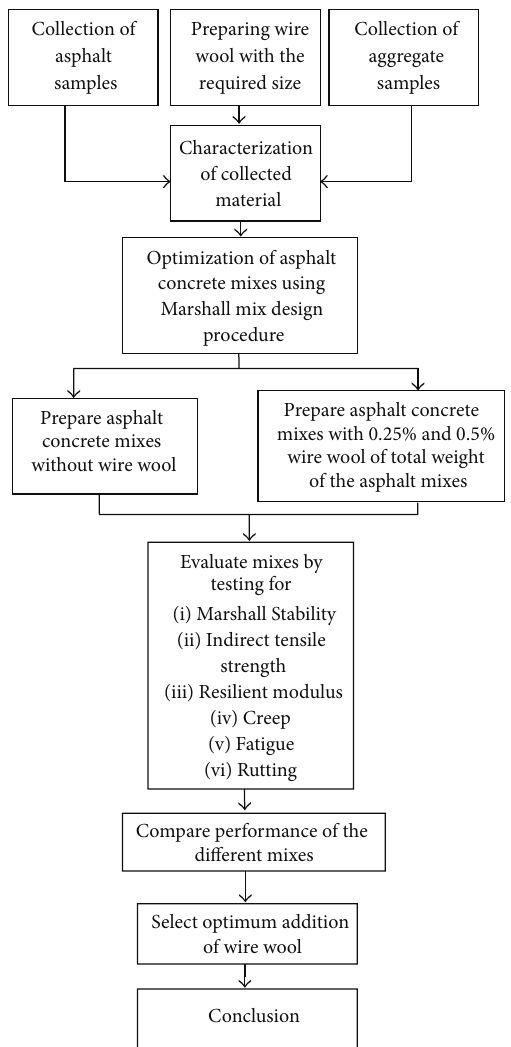
Figure 1: Flow chart of the experimental